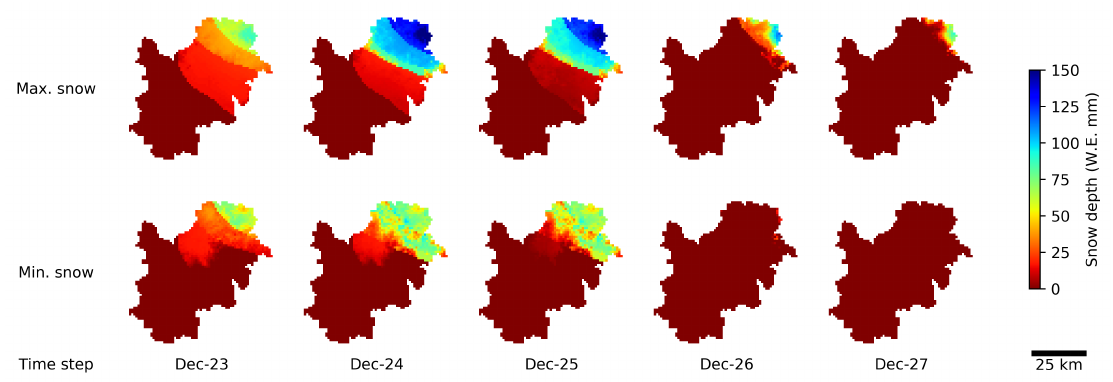
Figure 16. Available snow as snow water equivalent for two contrasting